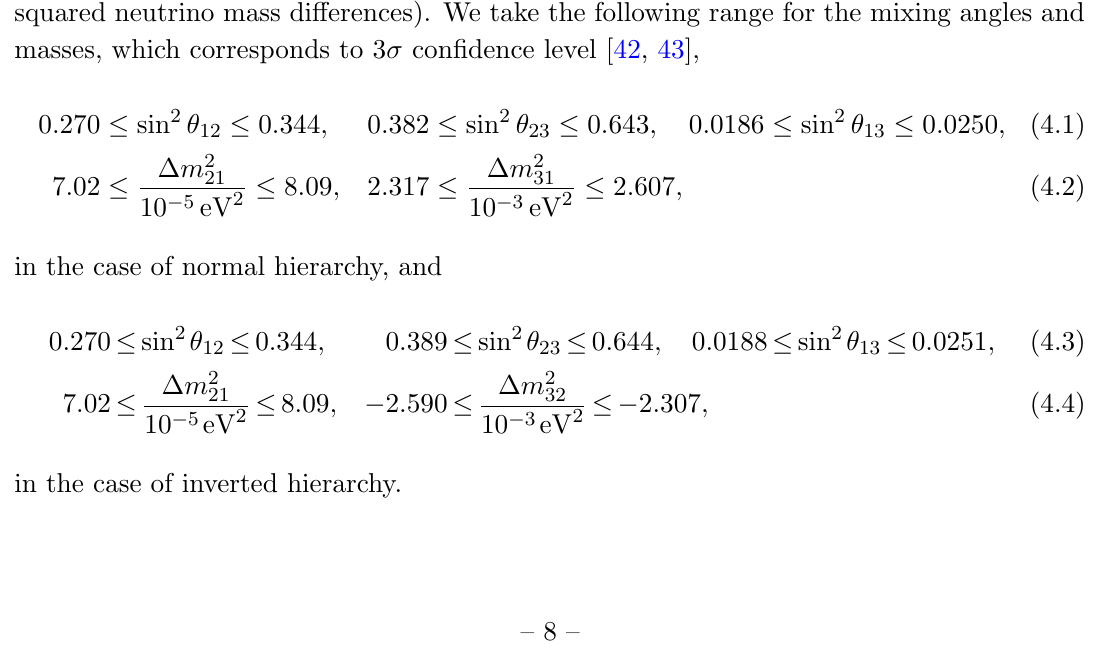
Figure 3 . Loop functions I M ( x i ; x j ) and I D ( x i ; x j ) as a function of x i where x j = m 2 (cid:12)xed to 0 : 1, 1 and